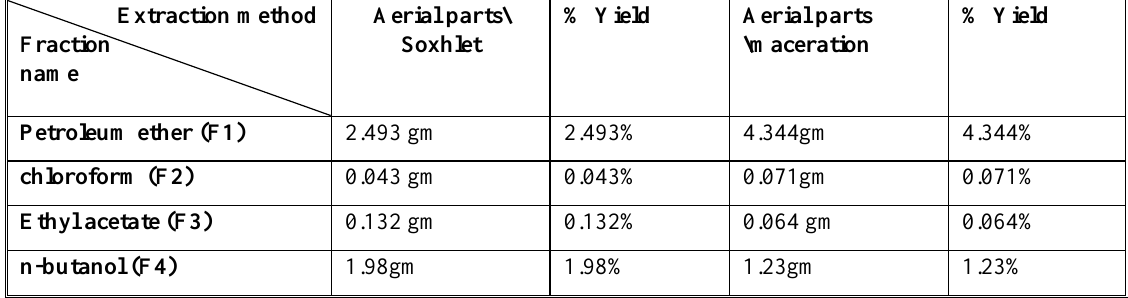
Table 1. The yield of aerial parts of the plant with the denoted method of